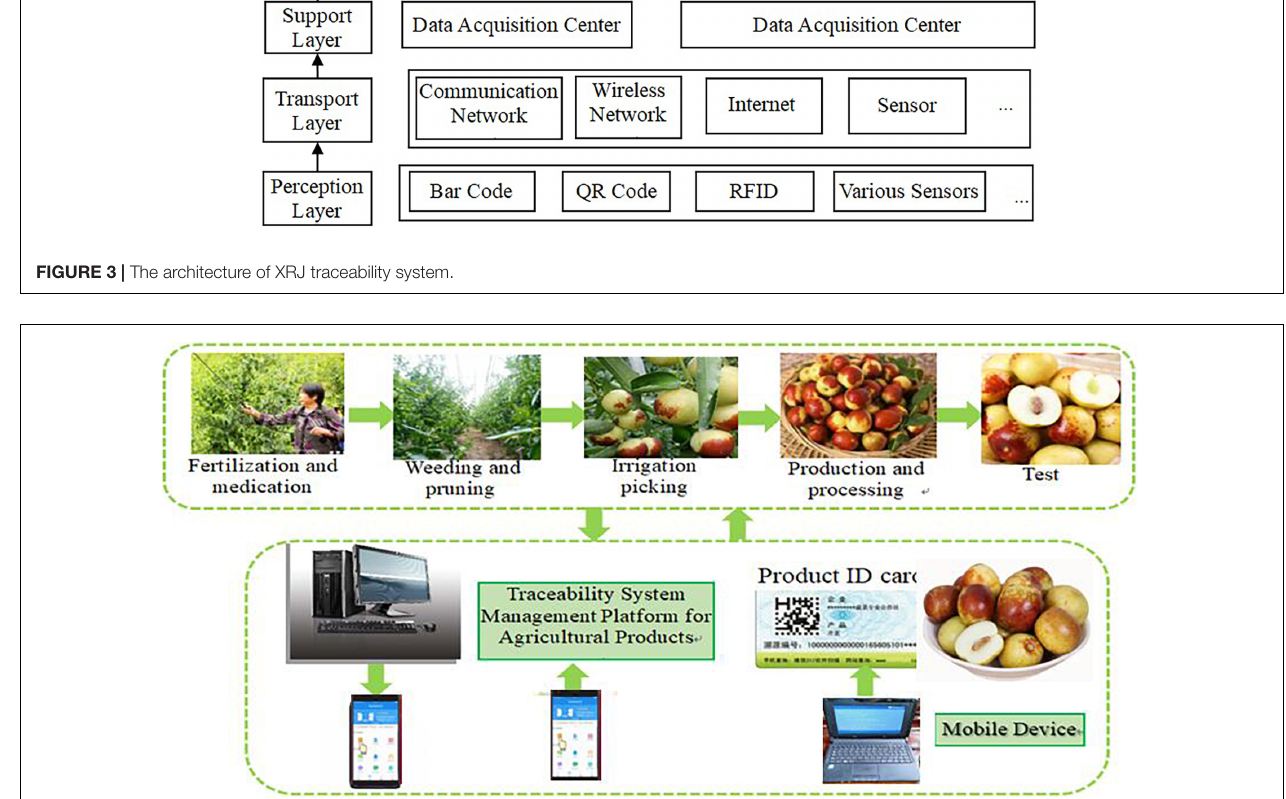
FIGURE 4 | The flowchart of XRJ traceability